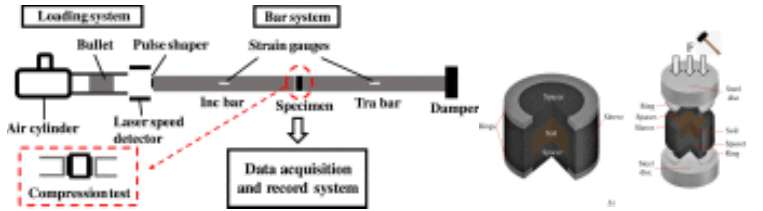
Figure 23. Schematic view of SHPB test stand and a specimen (reprinted from Ref. [87]). (XVIII)